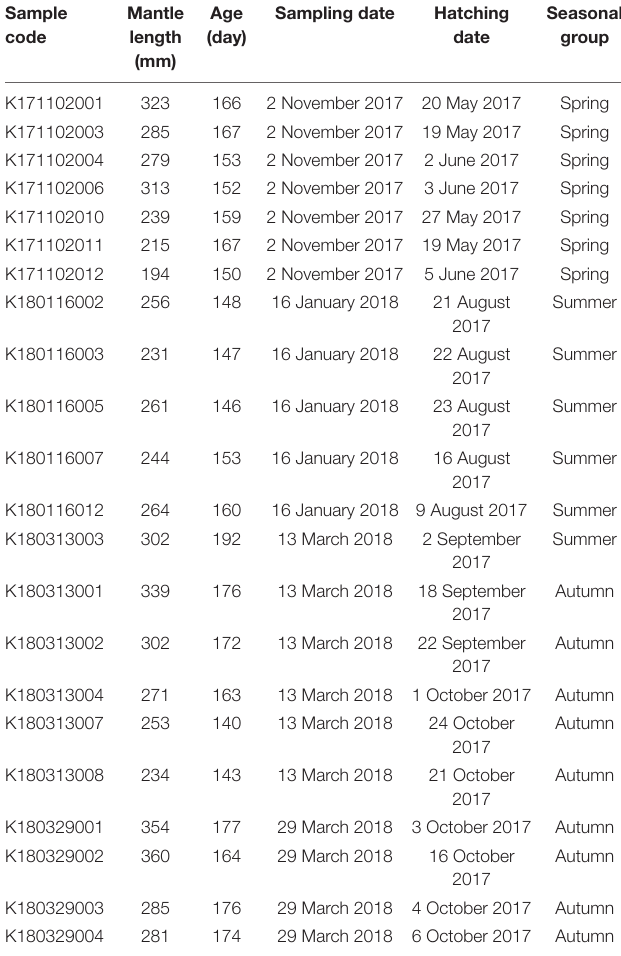
TABLE 1 | Sampling date, mantle length, age estimation, and back-calculated hatching date and season for each S. lessoniana individual used in statolith oxygen isotopic